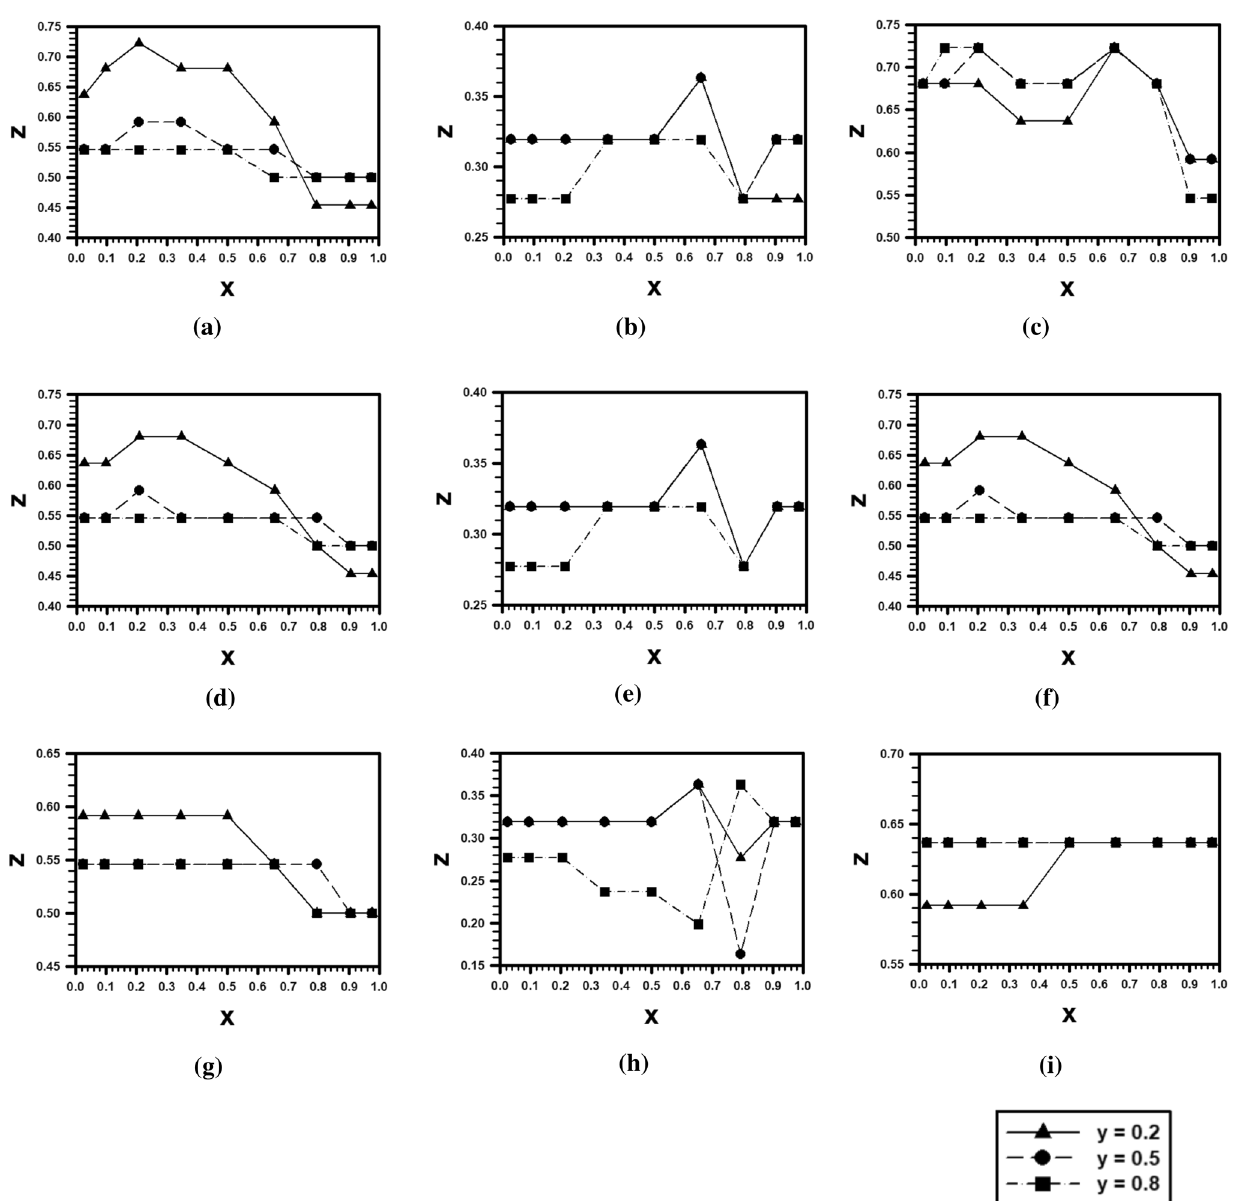
Fig. 11 A sample of the position of the maximum velocities of a longitudinal, b depth and c transverse for velocities of d longitudinal, e depth and f transverse for